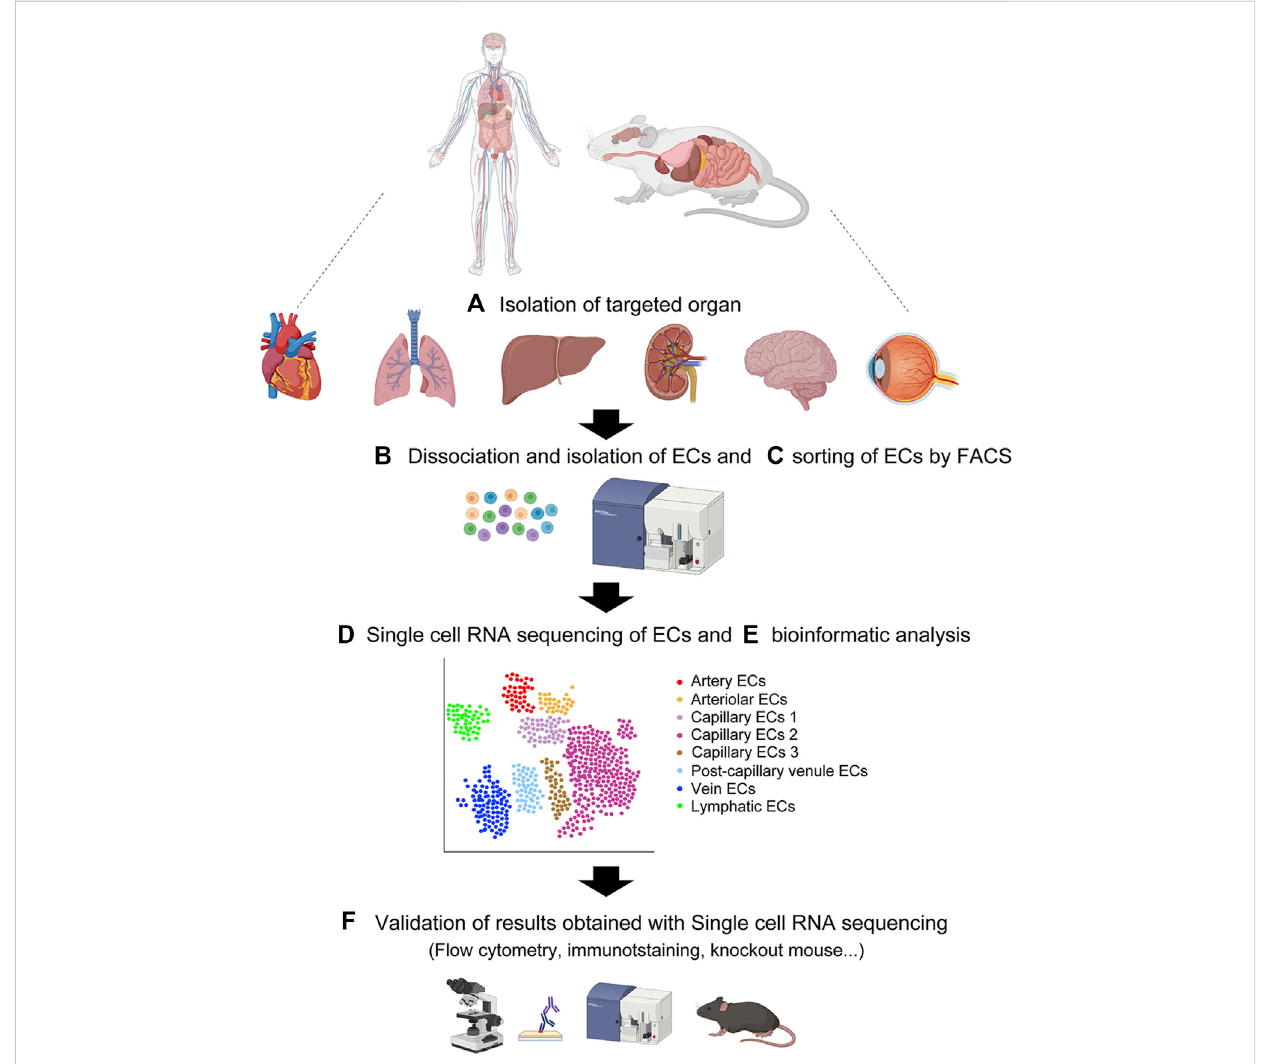
FIGURE 2 Overviewofsingle-cellRNAsequencing. (A) Isolationoftargetorgan. (B) Creatingsinglecellsuspensionbyenzymaticdigestion. (C) Flowcytometric sortingofCD31-positive CD45-negativevascular endothelial cells. (D) SinglecellRNAsequencingofthesinglecellsuspension. (E) Bioinformaticanalysis of the single cell transcriptomes. (F) Validation of results obtained with single cell RNA sequencing by various approaches. Created with